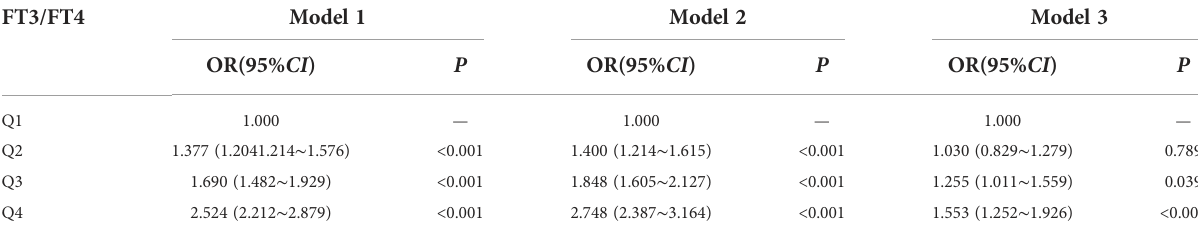
TABLE 5 Multivariate logistic regression analysis of the association between FT3/FT4 ratio and the risk of NAFLD. FT3/FT4